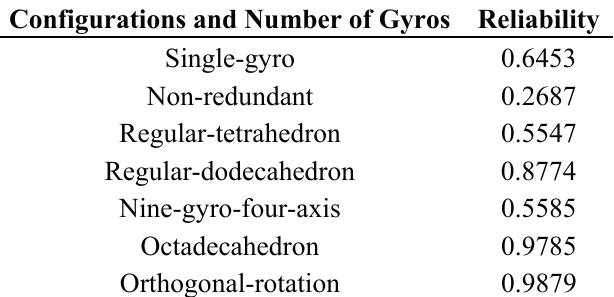
Table 2. Reliability of different